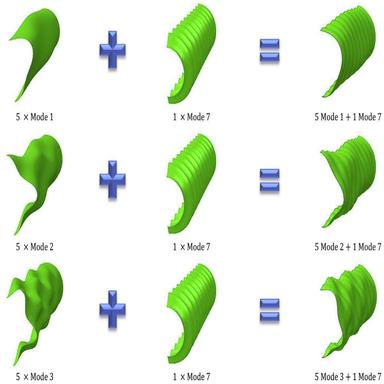
Linear superposition of eigenmodes.